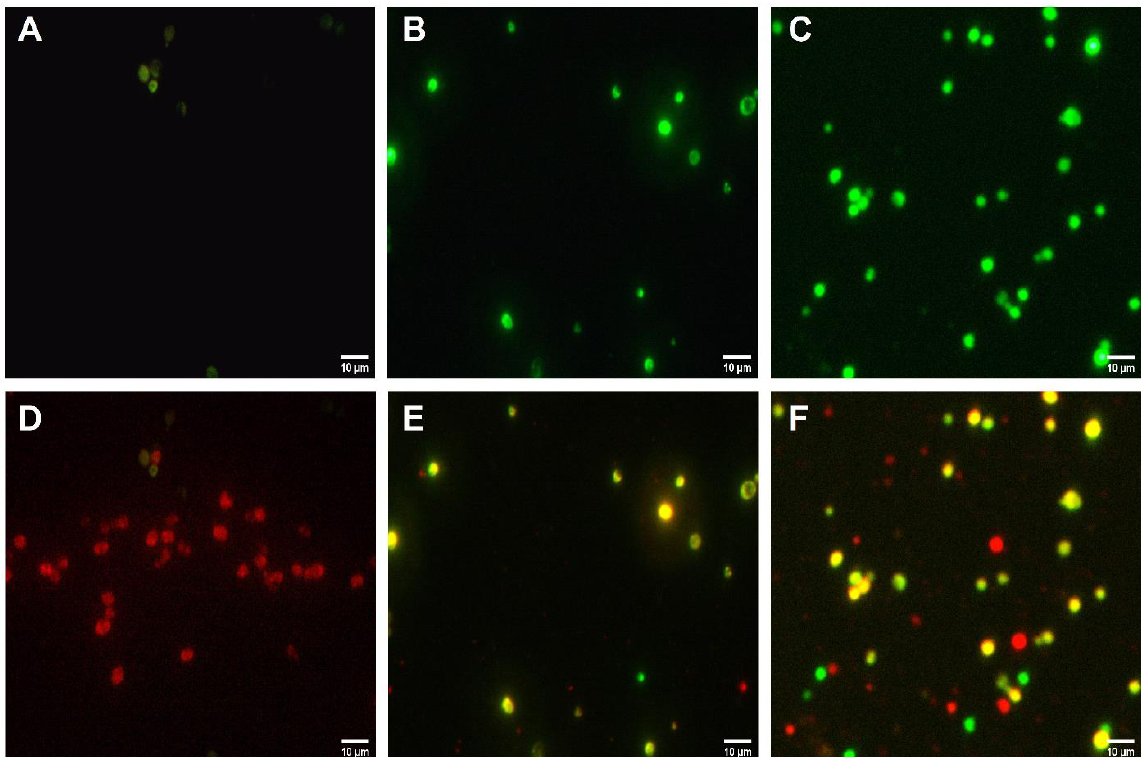
Figure 4. Live/Dead yeast viability method for caffeine (CAF) effects against C. albicans growth. The highest concentration of CAF (60 mg/mL) was tested. ( A – C ) Image showing dead fungal cells stained in green without treatments ( A ), with CHX treatment ( C ), and with CAF (60 mg/mL) treatment. ( D – F ) Image showing merged dead/live fungal cells stained in yellow-green or red-orange, respectively, after no treatments ( D ), after treatment with CHX ( E ), and after treatment with CAF (60 mg/mL) ( F ). Full plasma membrane integrity and metabolic function of yeast are needed to convert the yellow-green fluorescent into red-orange color.